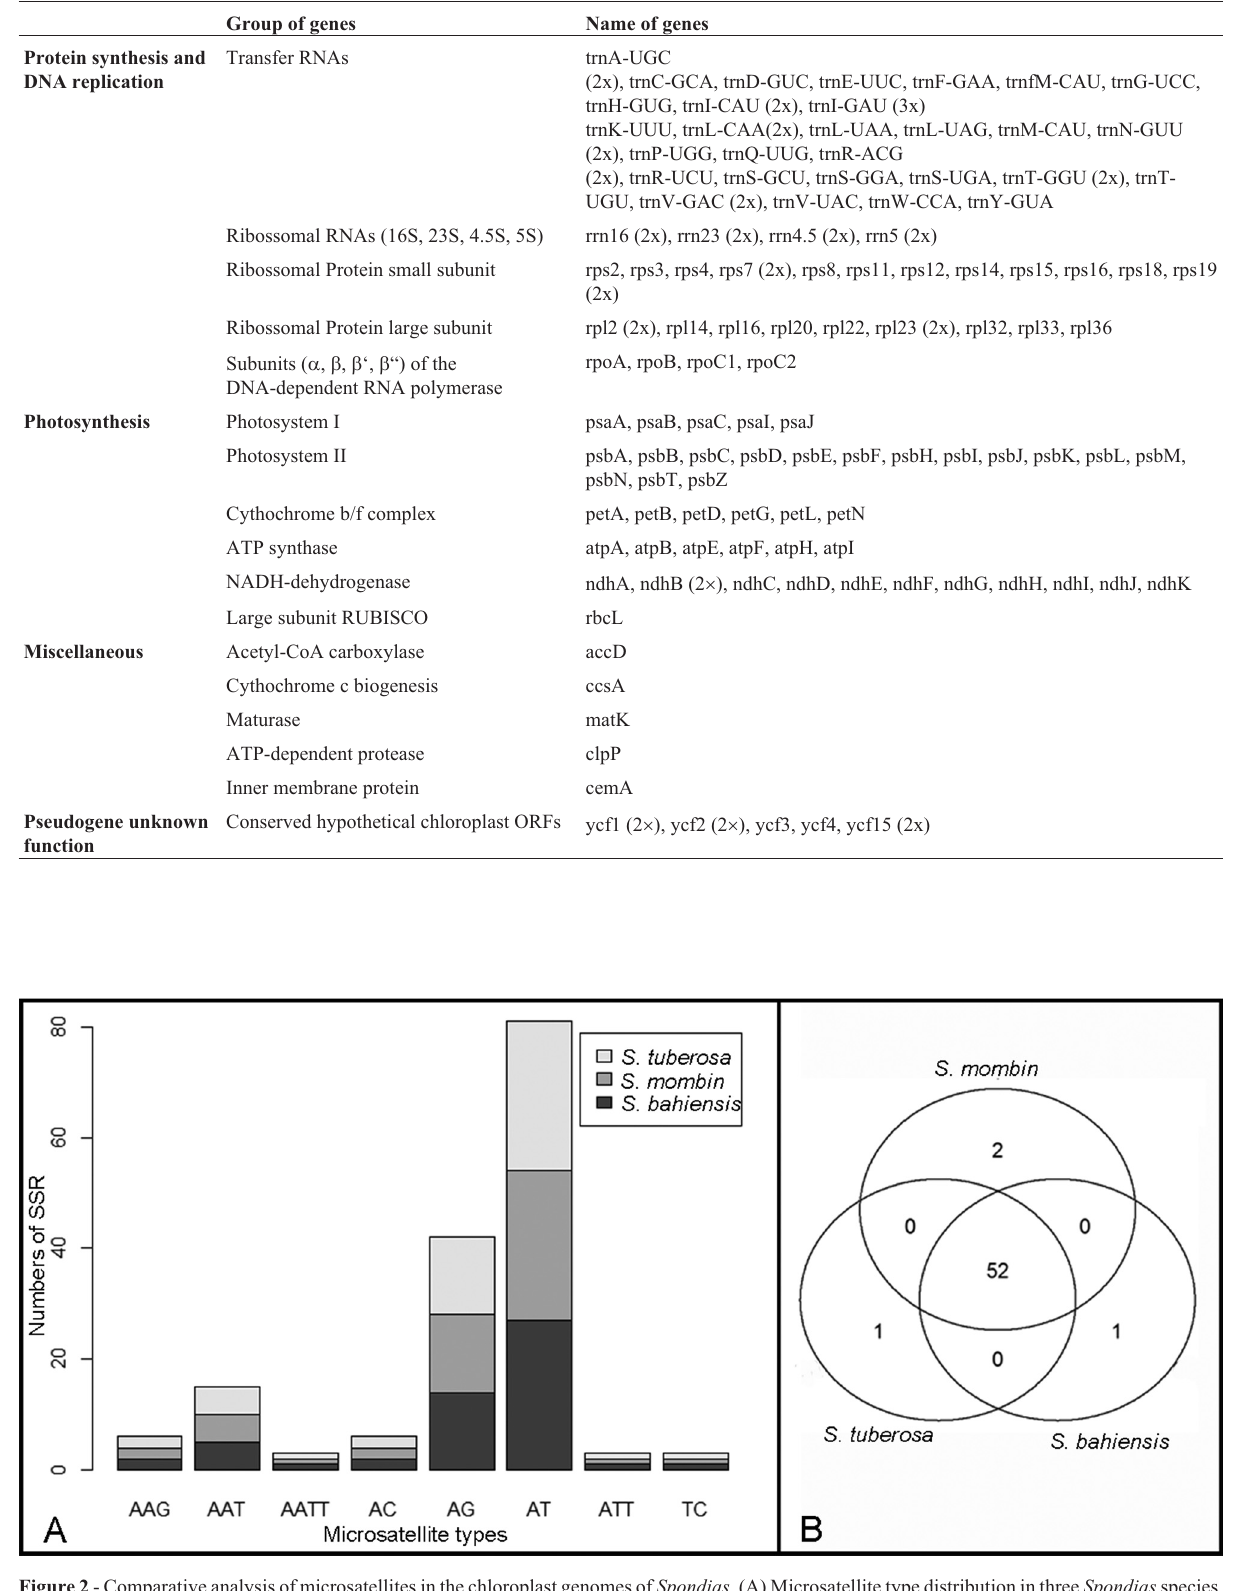
Table 3 - List of genes present in the Spondias tuberosa chloroplast genome, obtained by genome annotation using Sapindus mukorossi as reference.